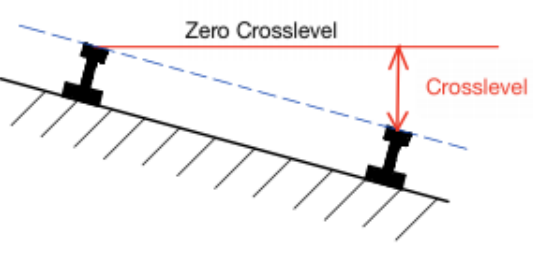
Figure 1. Crosslevel variation between two rails is illustrated.